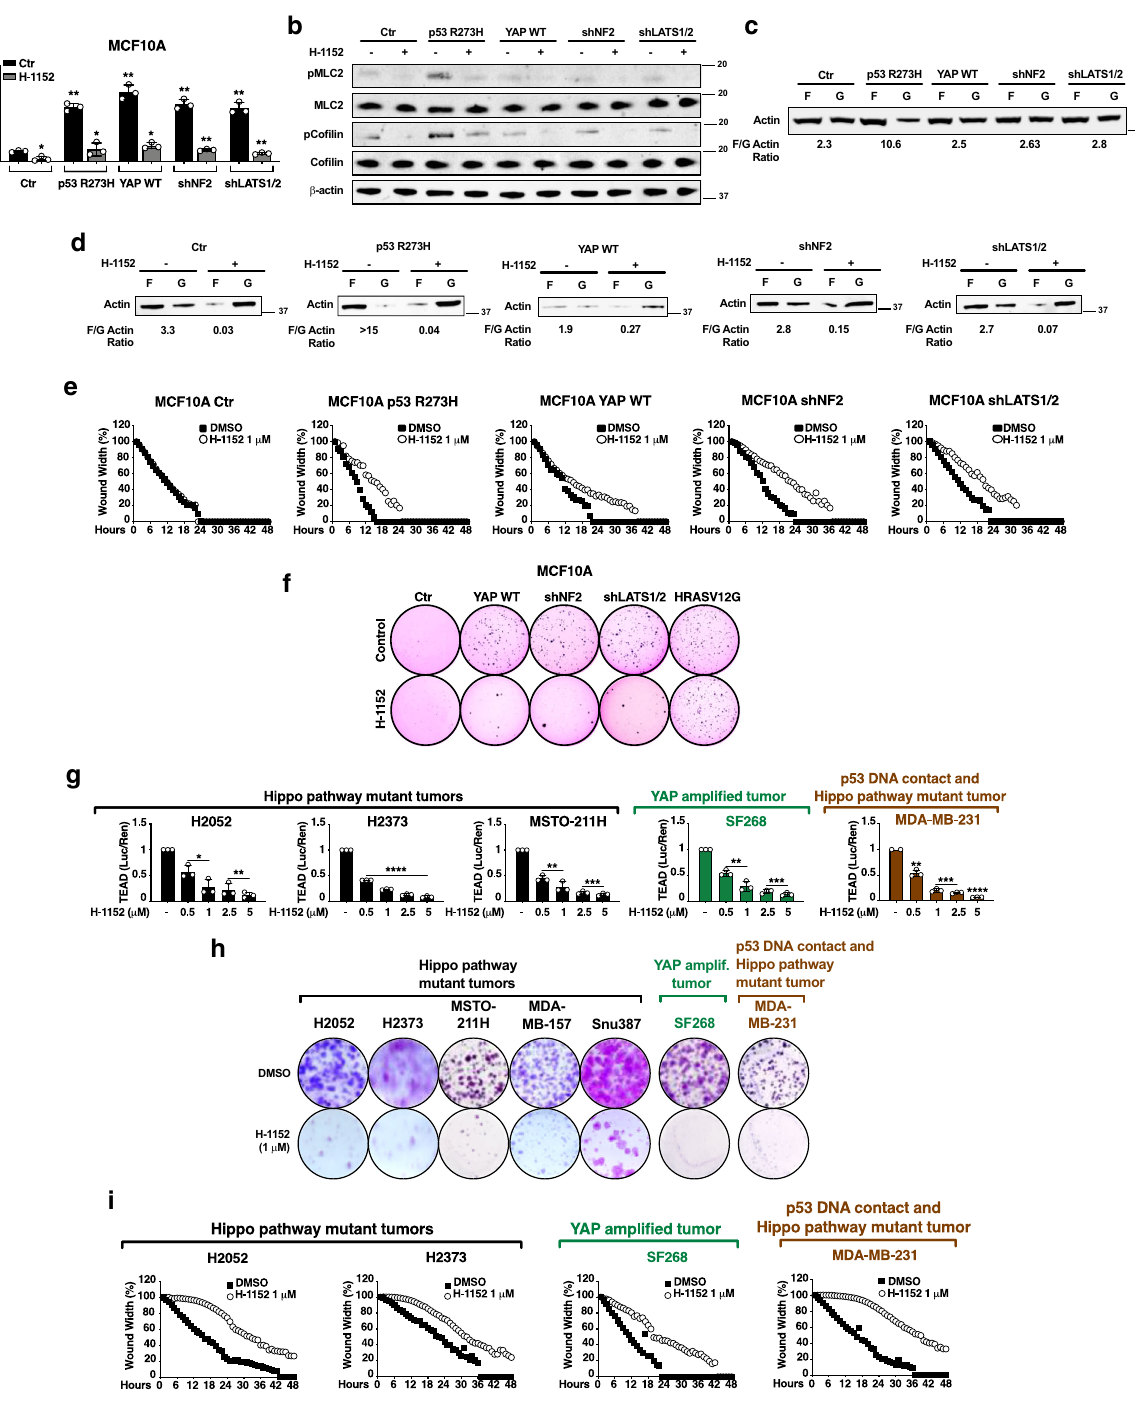
YAP WT in a common background of wild type MCF10A cells dysregulation of Hippo pathway function resulting from YAP (Supplementary Fig. 8). Each of these genetic manipulations exogenous overexpression or knockdown of NF2 or LATS1/2 did resulted in elevated levels of TEAD reporter activity compared to not affect physiological RhoA/ROCK mechano-signaling levels. control MCF10A cells (Fig. 3a). Of note, H-1152 markedly H-1152 treatment reduced basal phosphorylation levels of antagonized TEAD reporter activity in each case (Fig. 3a). ROCK downstream effectors (Fig. 3b) as well as basal levels of actin polymerization in each case (Fig. 3d). H-1152 treatment also markedly antagonized both motility (Fig. 3e) and agar colony formation by MCF10A cells expressing YAP WT, shNF2 or (Fig. 3b) and of actin polymerization (Fig. 3c), in response to shLATS1/2 (Fig. 3f) but had no effect on agar growth of MCF10A Hippo pathway dysregulation were indistinguishable from those cells expressing HRAS V12G (Fig. 3f), an oncogene that does not in control MCF10A cells. These results indicated that upregulate TEAD/YAP transcription 25 . All of these fi ndings NATURE COMMUNICATIONS| (2022) 13:703